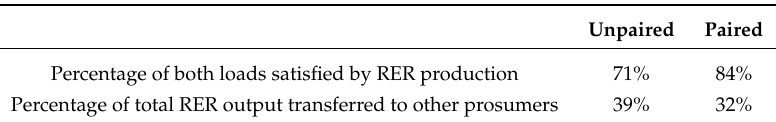
Table 2. Performance for both operating